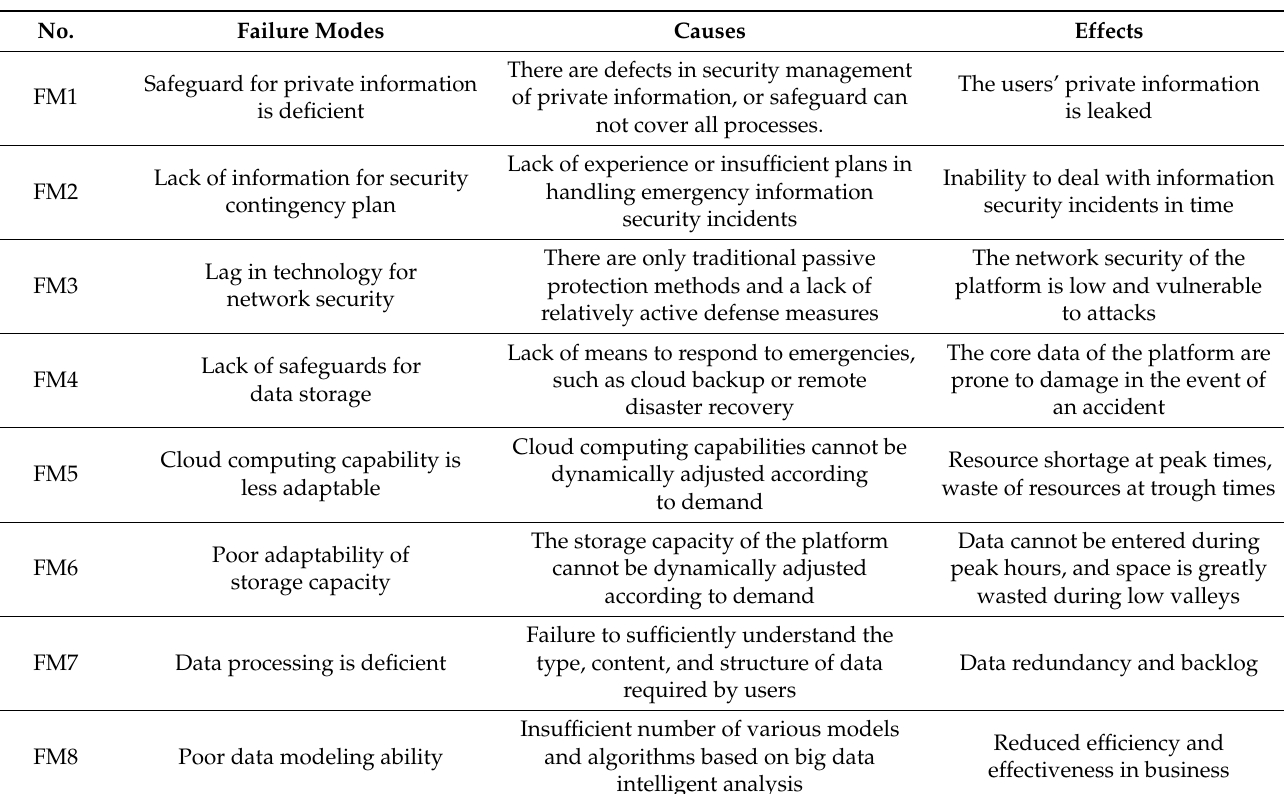
Table 7. Failure Modes for Industrial Internet